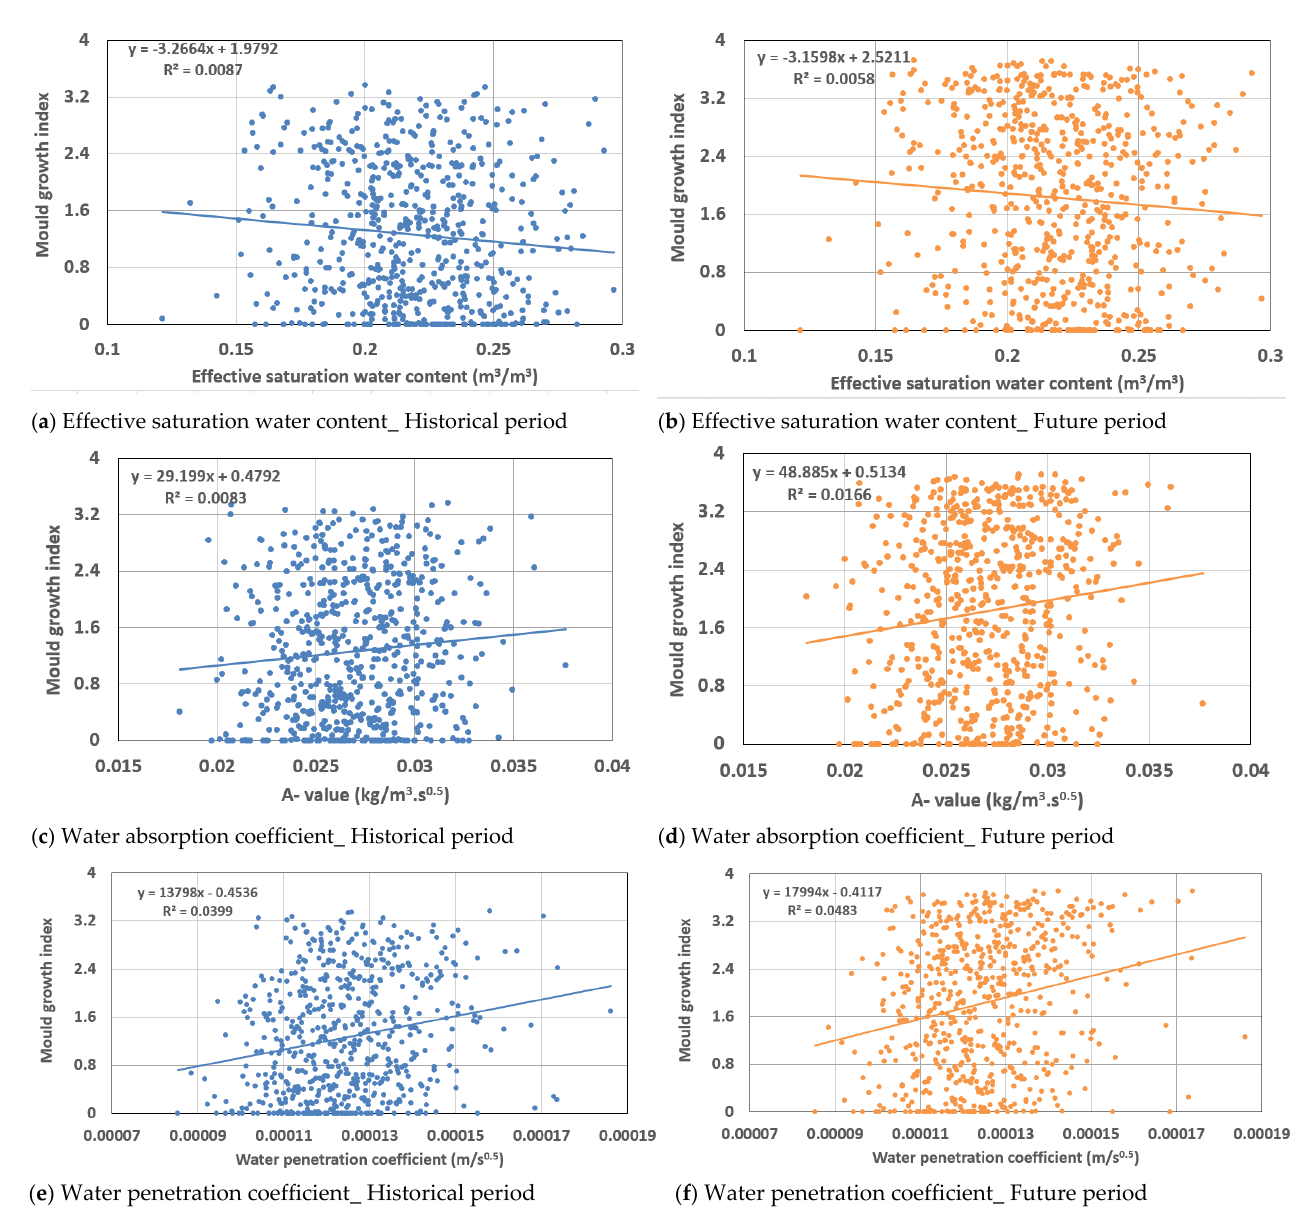
Figure 19. Scatter plots of 2-years’ averaged mould growth index against brick properties.